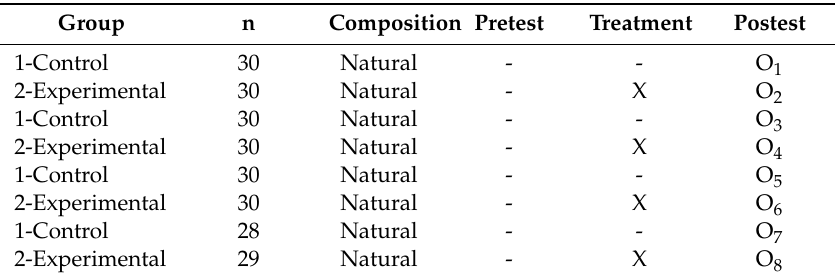
Table 1. Description of the